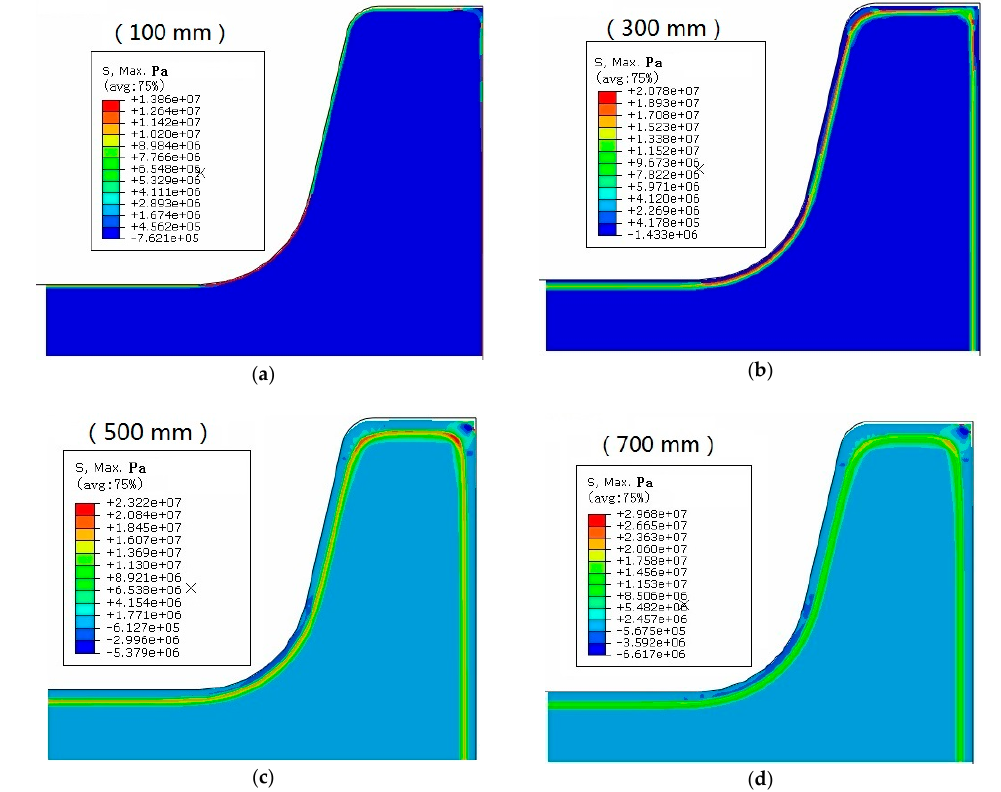
Figure 7. MAXPS contours of cross-sections at depths from the meniscus of ( a ) 100 mm; ( b ) 300 mm; ( c ) 500 mm and ( d ) 700 mm in the mold.